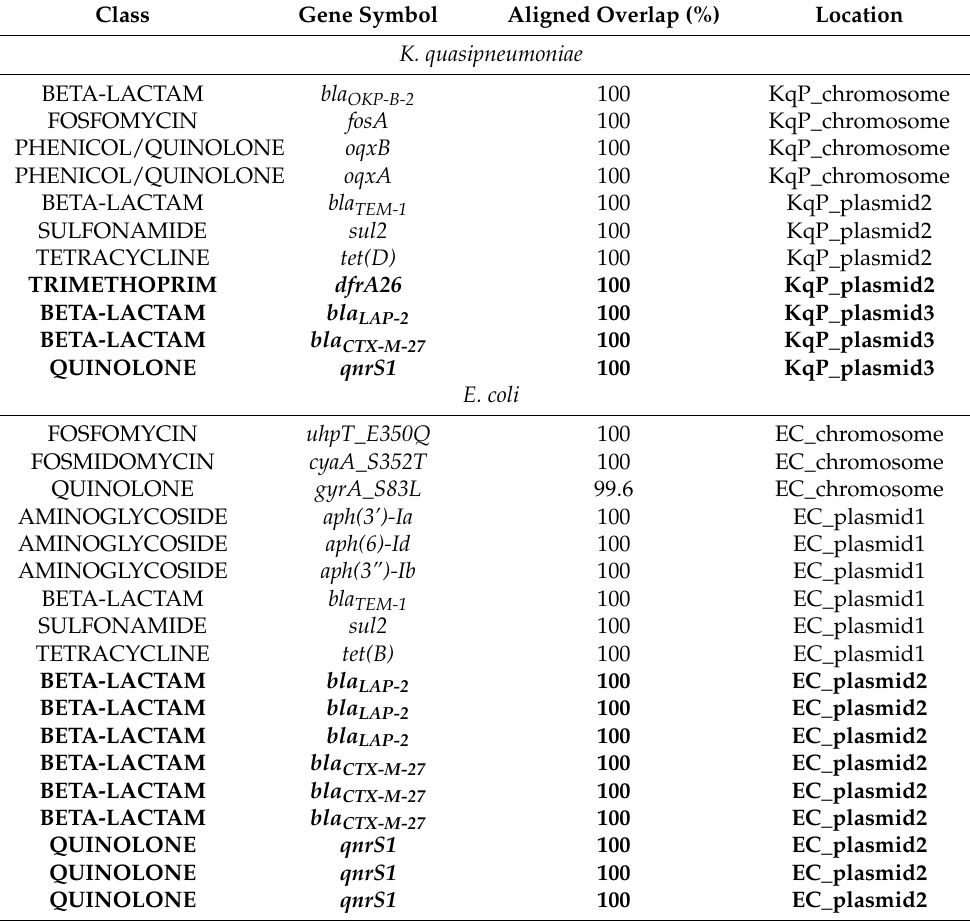
Table 2. ARGs identified by